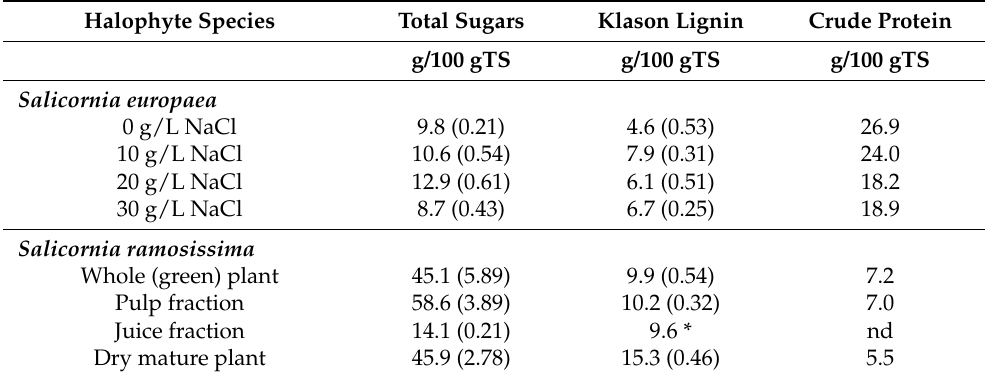
Table 3. Total sugars, lignin, and protein content of Salicornia samples in g/100 gTS, standard deviation of triplicates in